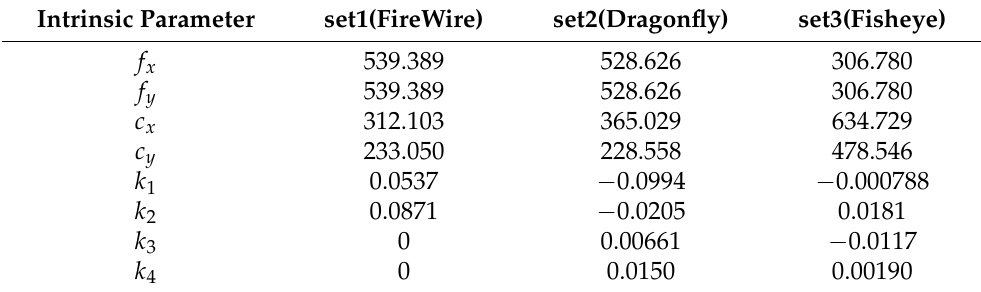
Table 6. The intrinsic parameters of the cameras in sRD-SIFT